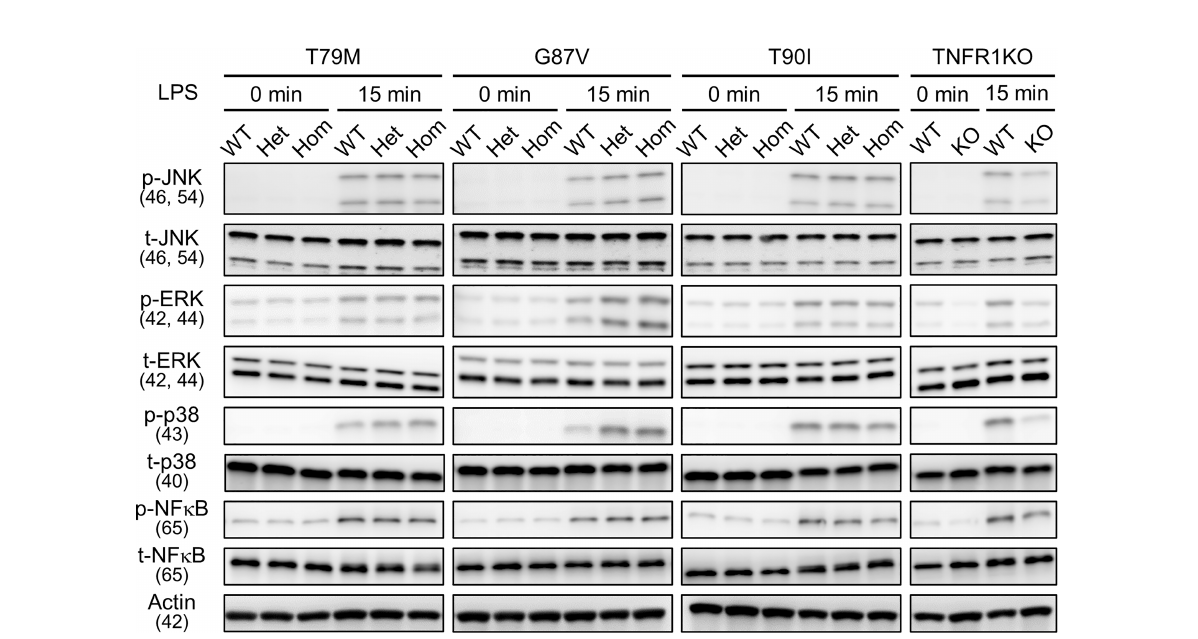
FIGURE 4 No substantial changes in LPS-induced activation of MAPK and NF- k B pathways by the TRAPS mutations. Primary murine bone marrow-derived macrophages with the indicated mutations were stimulated with 100 ng/mL LPS). Protein samples were collected before and 15 min after stimulation. Cell culture experiments were performed separately for each strain. Phospho- or total-JNK, ERK, p38, and NF- k B p65 levels were detected using speci fi c antibodies. Actin was used as a loading control. TRAPS, TNF receptor-associated periodic syndrome; LPS, lipopolysaccharide; NF- k B,